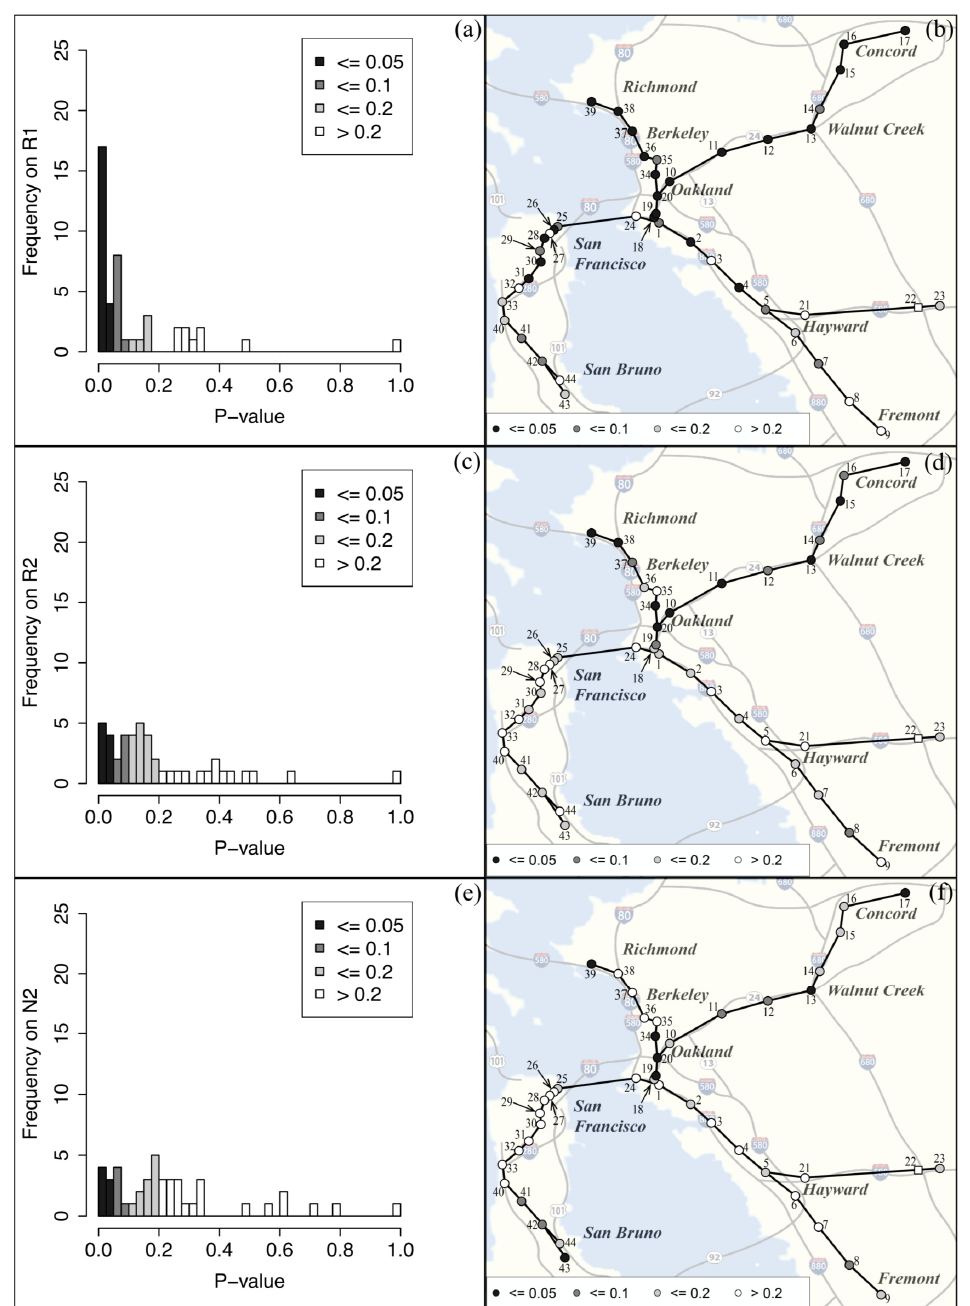
Figure 4. ( a ) Histogram of p ‐ values of the average weekday daily BART exit ridership during R1; ( b ) map of values shown in Figure 4a; ( c ) histogram of p ‐ values of the average weekday daily BART exit ridership during R2; ( d ) map of values shown in Figure 4c; ( e ) histogram of p ‐ values of the average weekday daily BART exit ridership during N2; and ( f ) map of values shown in Figure 4e.